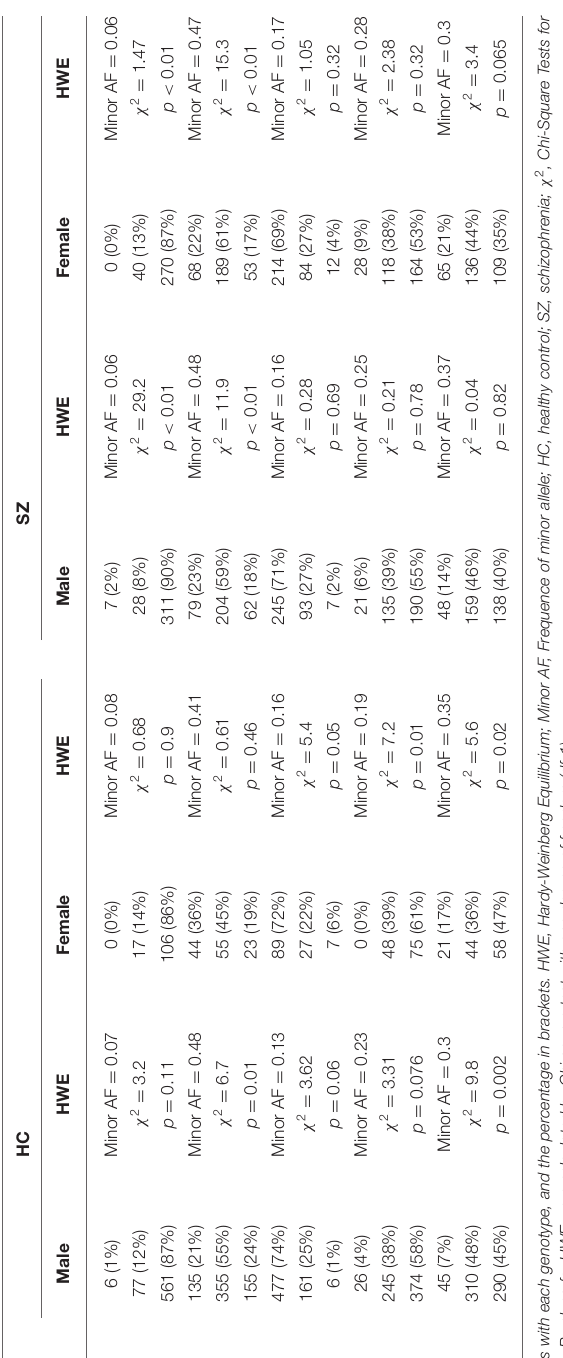
( Table 2 ). Comparison of allele frequencies in the case-control study: for SCL6A4 rs16965628 chi-squared = 0.3, p -value = 0.86; for HTR1A rs6295 chi -squared = 3.5, p -value = 0.18; for BDNF rs6265 chi -squared = 0.9, p -value = 0.64; for DRD3 rs6280 chi -squared = 5.92, p -value = 0.05; for HTR2A rs7322347 chi -squared = 13.3, p -value = 0.0013. not find significant associations. Nevertheless, we detected the associations with parameters of BFCRS: Waxy flexibility ( F = 4.83 p = 0.0085), Negativism ( F = 4.28 p = 0.01), Stupor ( F = genotype T/T ( Met66Met polymorphism) demonstrated higher